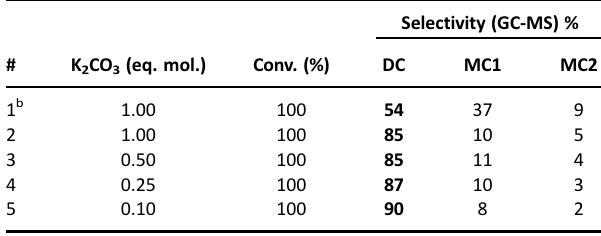
Selectivity (GC-MS)